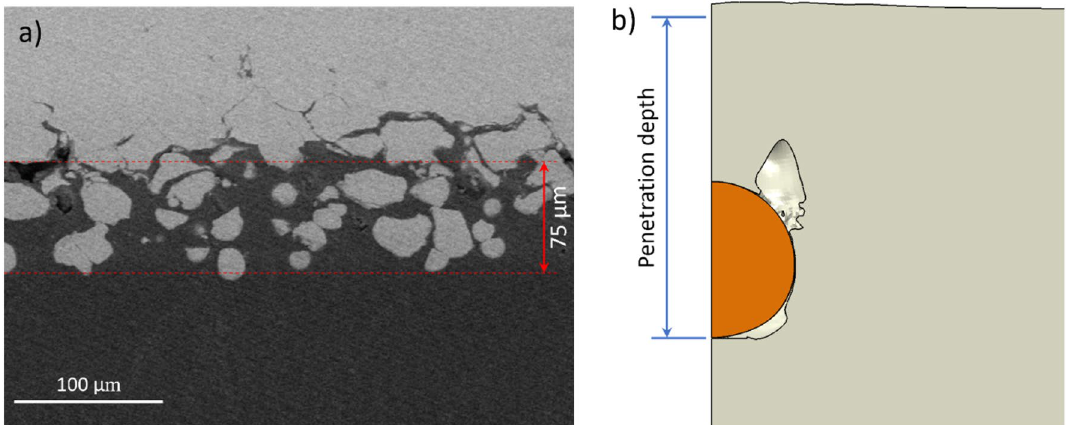
Figure 11. ( a ) Cross-ional view of the interface for Cu coating and PEEK substrate deposited using cold spray parameters listed in Table 1 ( b ) numerical simulation of a single Cu particle impact on PEEK with a constant substrate temperature of 200 °C at 4.0×10 −7